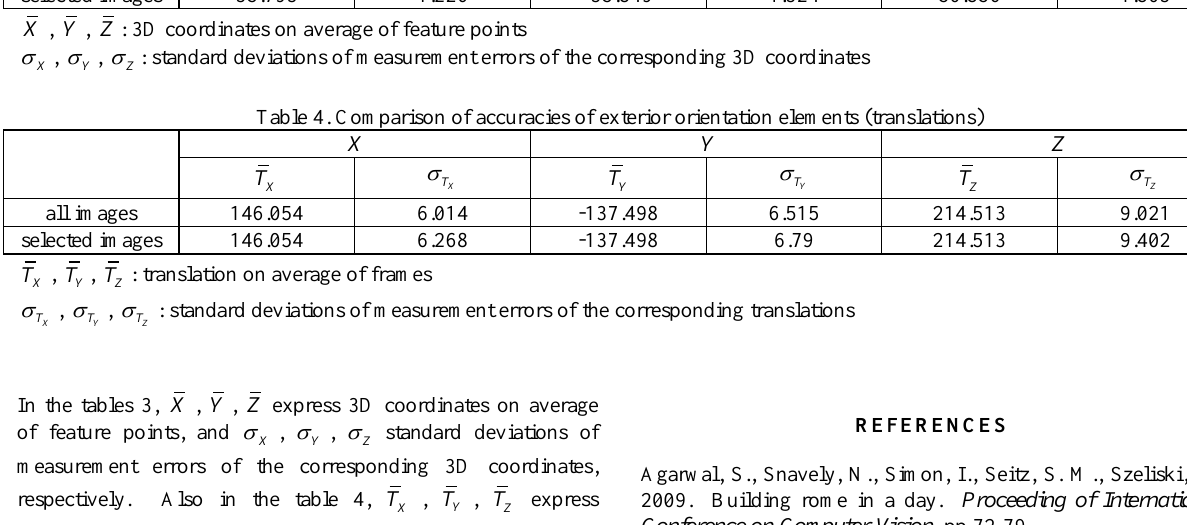
Table 3. Comparison of accuracies of 3D coordinates of feature points X Y Z X X 